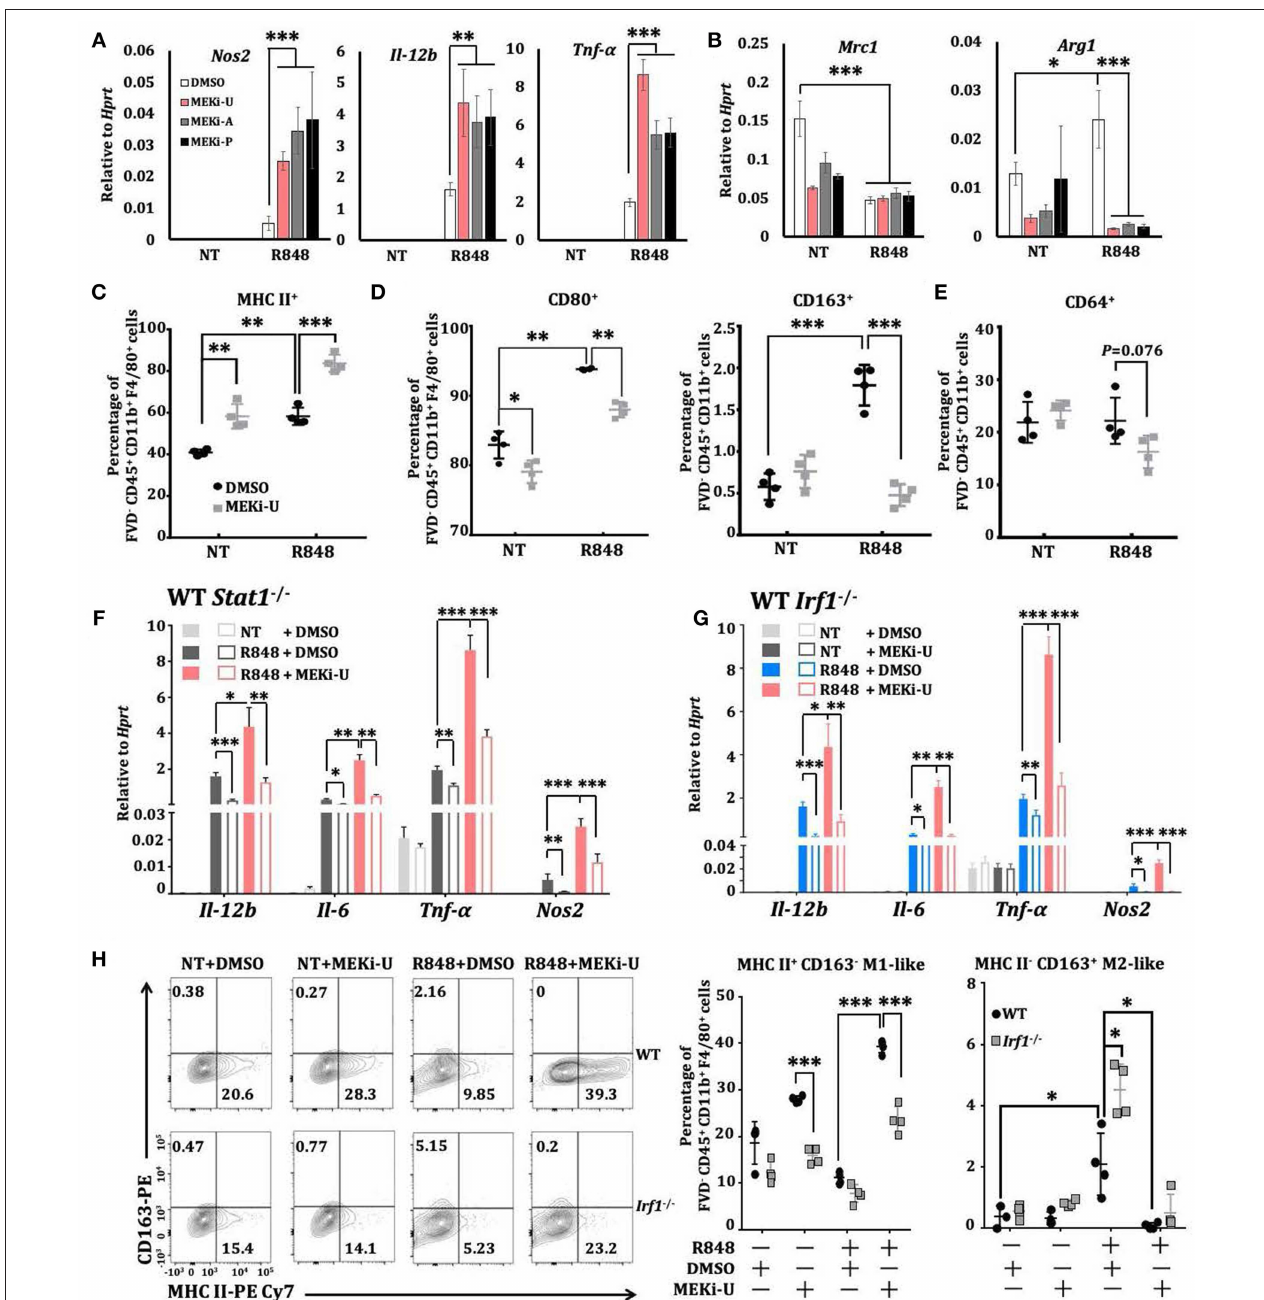
FIGURE 6 | Macrophages are reprogrammed toward a predominantly M1-like phenotype through IRF1. (A,B) qRT-PCR analysis of Nos2, Il-12b, and Tnf α (A) or Mrc1 and Arg1 (B) mRNA expression in BMDMs activated with TLR7 agonist R848 for 6h in the presence or absence of different MEK1/2 inhibitors. Data are means ± SD pooled from 4 experiments. (C–E) Flow cytometry analysis of MHC II (C) , CD80 and CD163 (D) , and CD64 (E) surface expression on BMDMs stimulated with R848 for 24 h in the presence or absence of MEKi-U. Data with means ± SD are from 4 independent experiments. (F,G) qRT-PCR analysis of the indicated mRNAs expressed in WT and Stat1 − / − (F) or Irf1 − / − (G) BMDMs activated with TLR7 agonist R848 for 6h in the presence or absence of different MEK1/2 inhibitors. Data are means ± SD pooled from 4 experiments. (H) Flow cytometry analysis of MHC II + CD163 − M1 and MHC II − CD163 + M2 phenotypes in WT and Irf1 − / − mice BMDM stimulated with R848 for 24h in the presence or absence of MEKi-U. Contour plots are representative of 4 independent experiments. Quantified% positive data with means ± SD are from all experiments. * P < 0.05, ** P < 0.01, and *** P < 0.001 by one-way ANOVA (A,B) with Bonferroni’s correction (F,G) or unpaired Welch’s t -test (C–H) .